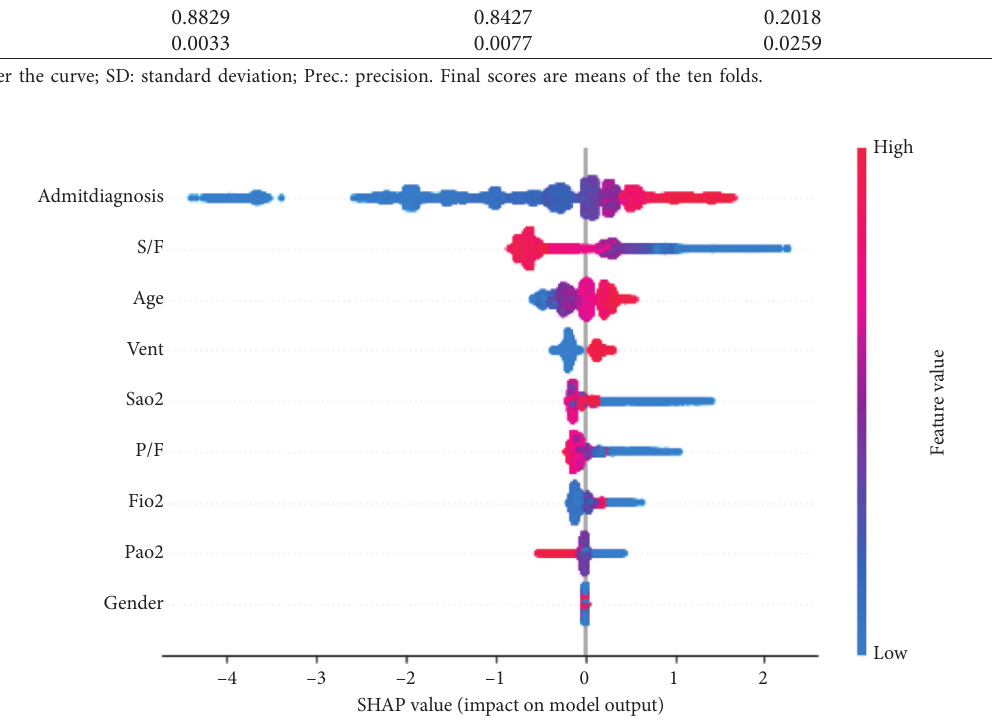
Figure 3: SHAP table demonstrating feature importance ranked in descending order on y -axis. x -axis with the SHAP values. Negative SHAP value predicts a low probability of death at a high or low value of that feature value (blue � low value; red � high value). Positive SHAP value demonstrates a high probability of mortality at that feature value. Low S/F values (blue) predict a high likelihood of death, whereas high values (red) predict a low likelihood. PaO 2 : partial pressure of oxygen; FiO 2 : fraction of inspired oxygen; SaO 2 : oxygen saturation; P/F: PaO 2 and FiO 2 ratio; S/F: SaO 2 and FiO 2 ratio; S/F: SaO 2 /FiO 2 , P/F: PaO 2 /FiO 2 ; Vent: mechanical ventilation.